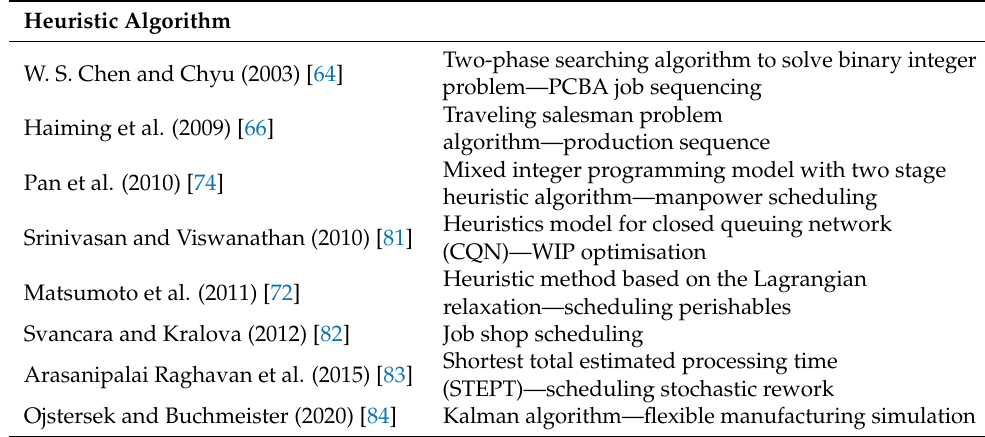
Table 4. List of algorithms used and their objectives. Heuristic